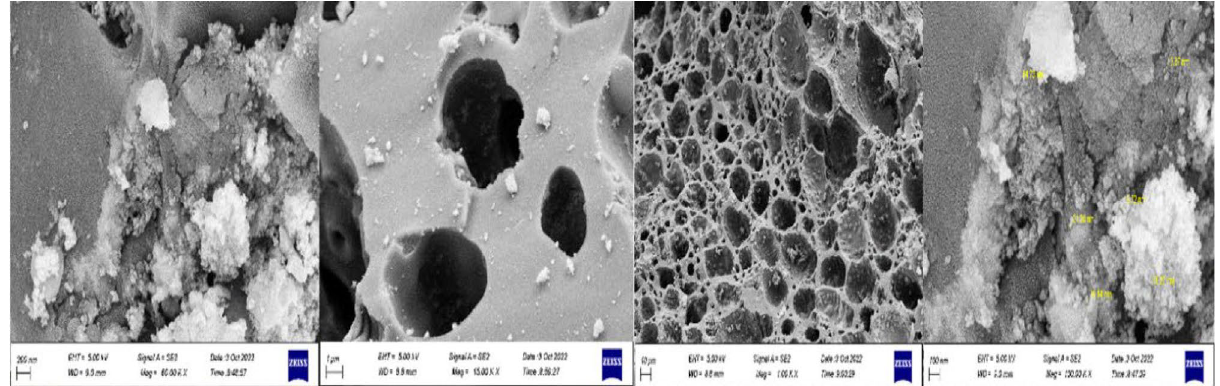
Figure 2. FESEM of the Ni 0.5 Co 0.5 Fe 2 O 4 @AC/Ch magnetic nanobiocomposite.